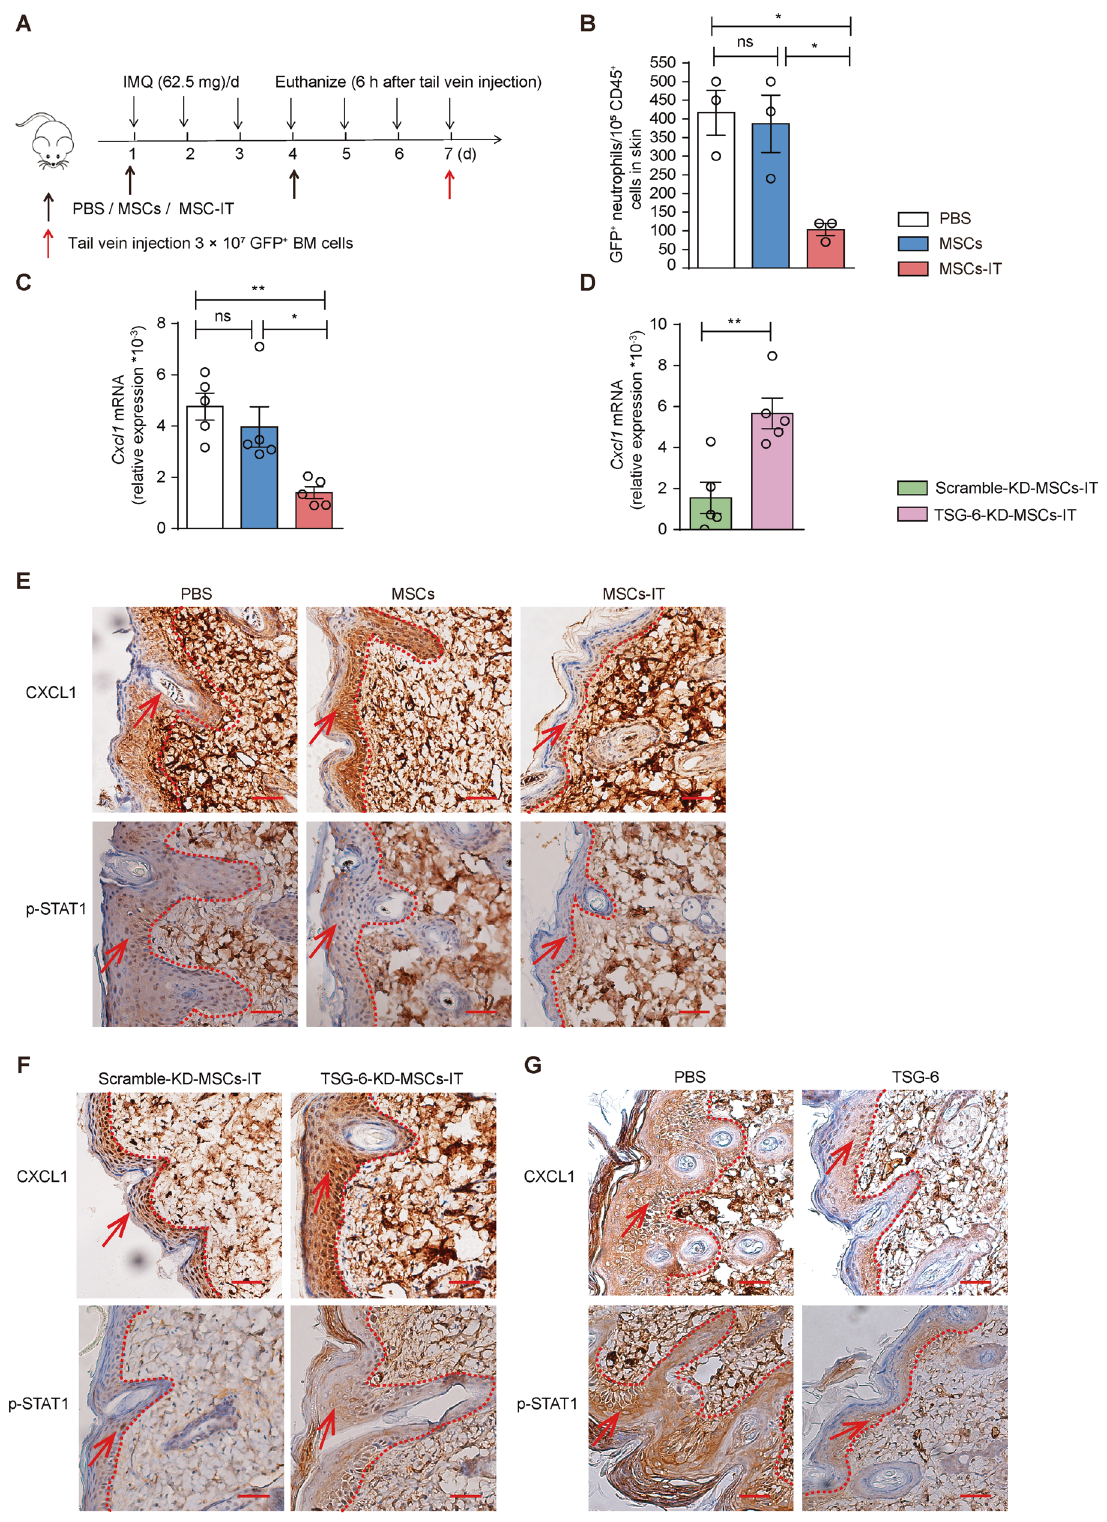
Fig. 6 MSCs-IT downregulated CXCL1 via TSG-6. Bone marrow cells from GFP mice were infused into mice on day 7 of MSC treatment. Flow cytometry was used to analyze the proportion of GFP-positive neutrophils in the lesions 6 h later ( n = 3 mice for each group). A The experimental scheme. B Enumeration of GFP positive neutrophils in the indicated groups, including IMQ + PBS group, IMQ + MSC group, and IMQ + MSC-IT group. In addition, we further examined the CXCL1 expression ( n = 5 mice for each group). C The relative expression of Cxcl1 in the indicated groups. D The relative expression of Cxcl1 in the scramble-KD-MSC-IT group and TSG-6-KD-MSC-IT group. E – G The CXCL1 and p-STAT1 immunostaining of skin in the indicated groups. Scale bars: 50 µm. Data were shown as means ± SEM, * p < 0.05, ** p < 0.01, ns: not signi fi